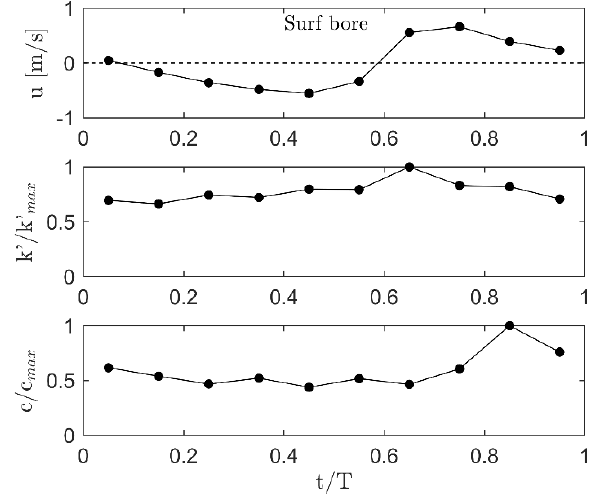
Figure 18. Ensemble-averaged cross-shore velocity (upper panel) and normalized k (middle panel) and suspended sediment concentration at z = 5 cm (lower panel) under asymmetric surf bores in the intertidal zone at Vejers Beach, Denmark. Bedforms were absent, the relative wave height, γ s = 0.64, and velocity asymmetry AS u = 1.95. From Christensen et al. [86].